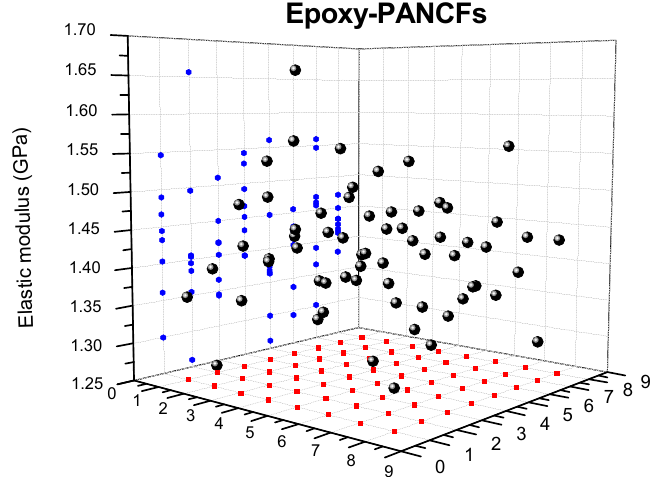
Figure 9. Elastic modulus obtained from the loading ‐ unloading mapping measurements at 200 nm of displacement for the epoxy ‐ PAACFs sample.